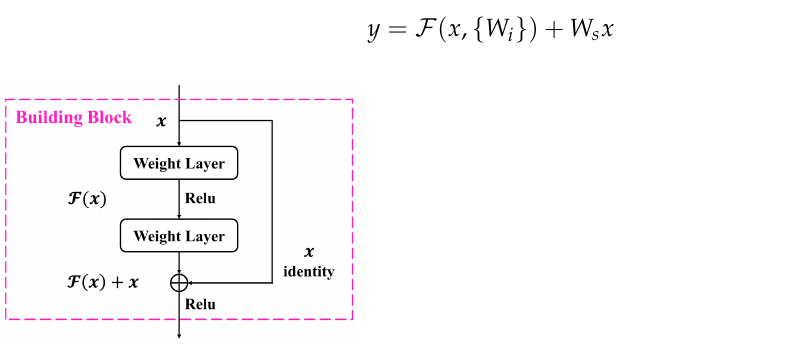
Figure 2. A building block in residual learning.